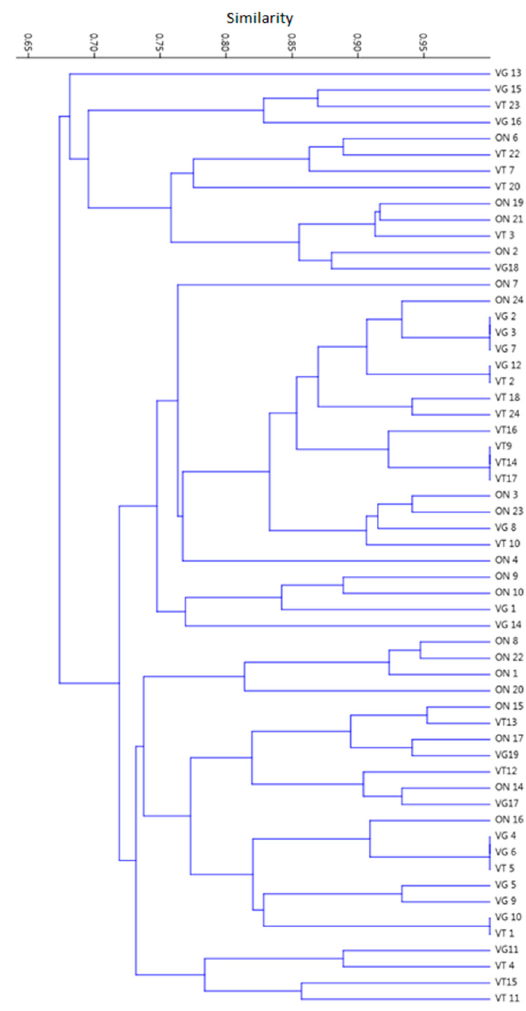
Figure 4. Clustering analysis of 58 healthy individuals with different eating habits (omnivores (ON), ovolactovegetarians (VT), and strict vegetarians (VG)) related to polymerase chain reaction (PCR) screening of antimicrobial resistance genes (ARG), representative of the human gut clinical resistome. The dendrogram was obtained from a binary matrix built based on positive or negative amplification of each tested ARG, using the Unweighted Pair Group Method with Arithmetic Mean (UPGMA) grouping method.